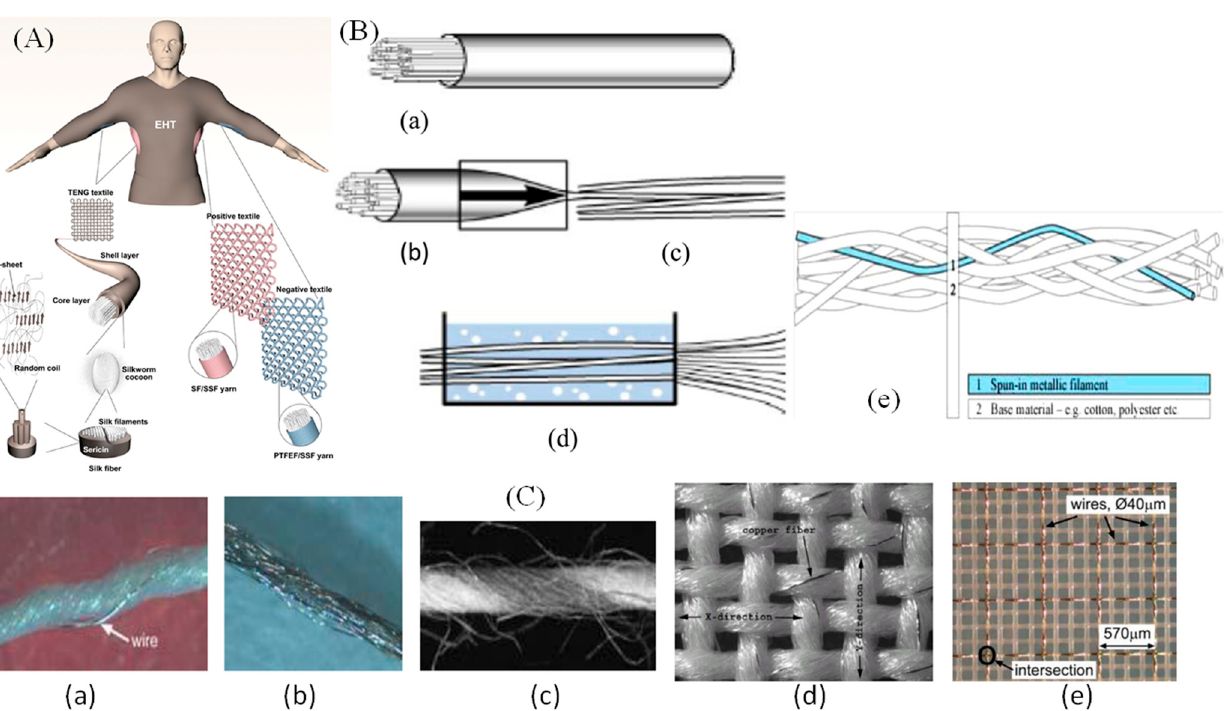
Figure 2. ( A ). Ultrastable and high-performance silk energy harvesting textiles; ( B ). ( a ) Iron tube; ( b ) reducing diameter; ( c ) tube building; ( d ) forming fibres and ( e ) conductive fibre diagram wrapped with the typical fibres; ( C ). ( a ) Twisted metal wire; ( b ) coated metal; ( c ) metal multi-filaments; ( d ) copper-polyester twisted yarn and ( e ) base fabric with embedded copper wire [10,40,41].